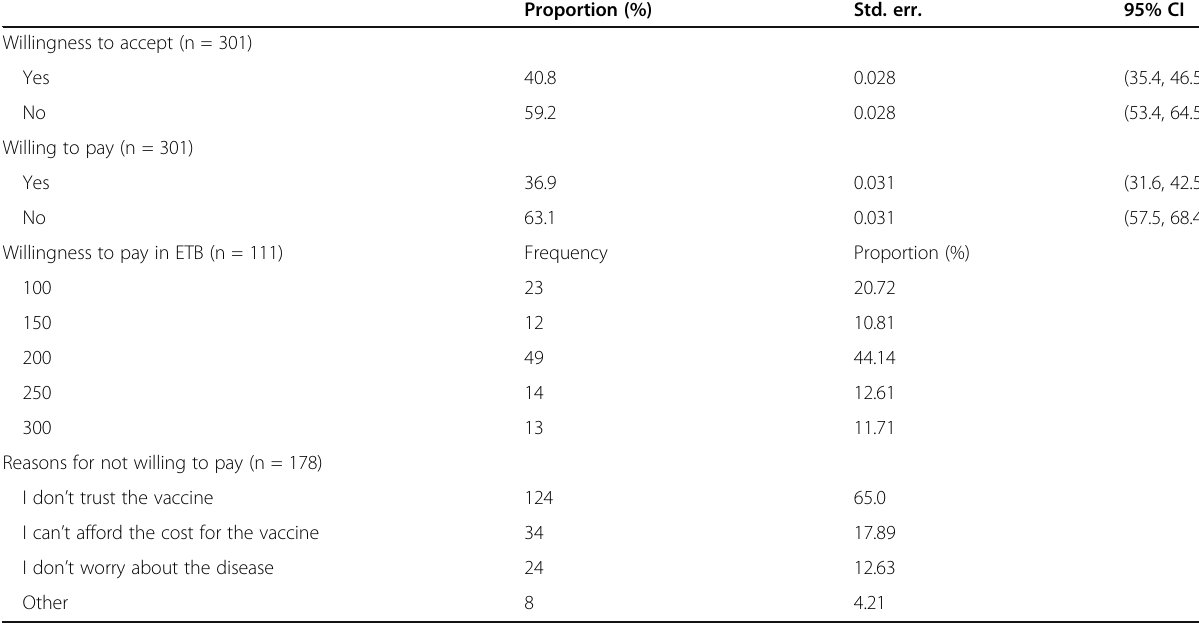
Table 2 Willingness to accept and pay and reasons for not willing to pay for COVID-19 vaccine among school teachers in Gondar City, Northwest Ethiopia Proportion (%) Std. err. 95%